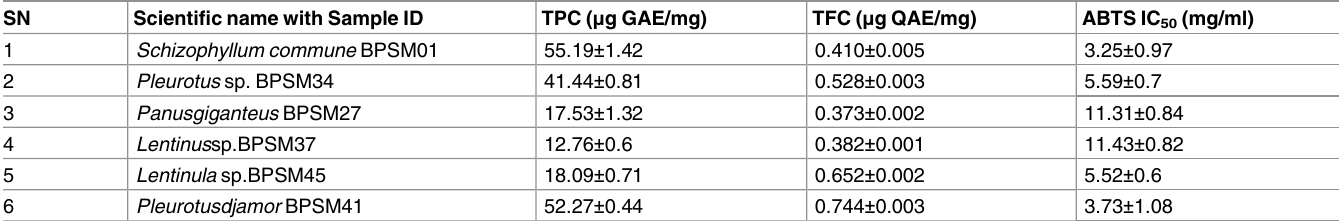
Table 6. Antioxidant activity of wild mushrooms.